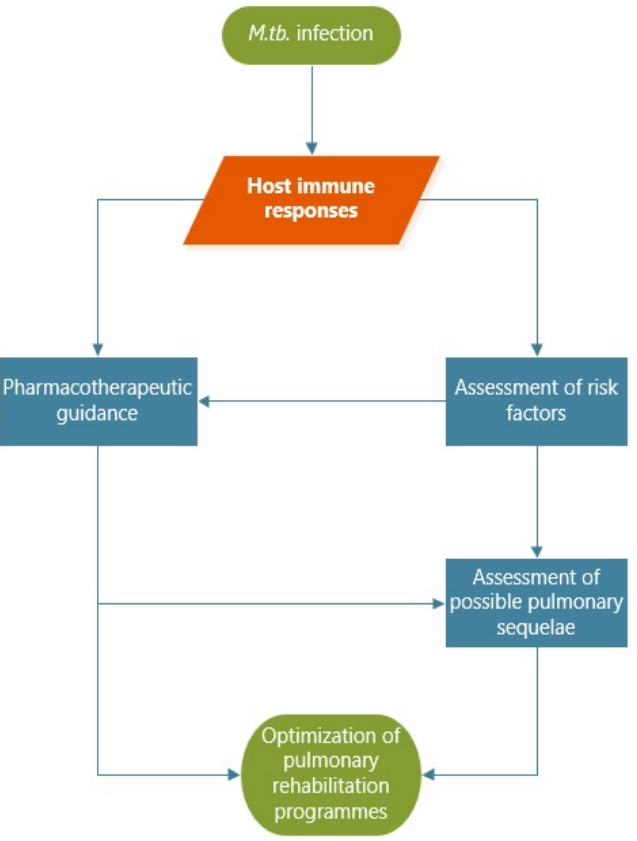
Figure 1. Multidisciplinary study purpose.